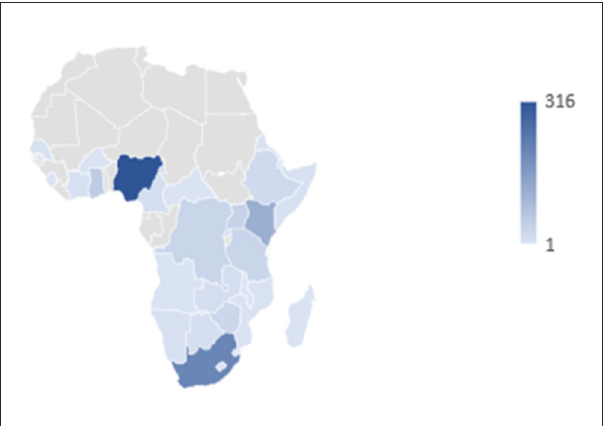
FIGURE4 Map showing which countries in sub-saharan Africa were part of the social media conversations.